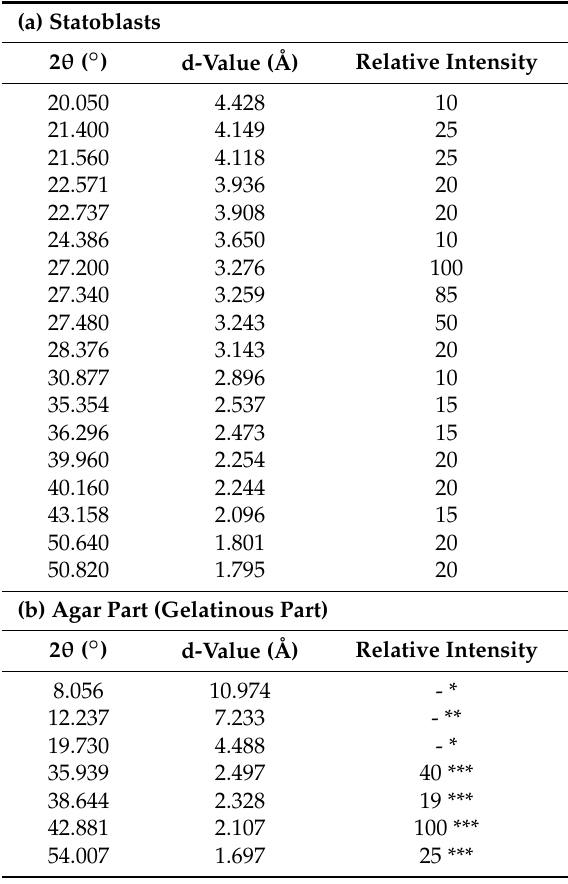
Table 5. Peak positions and d values of XRD patterns.